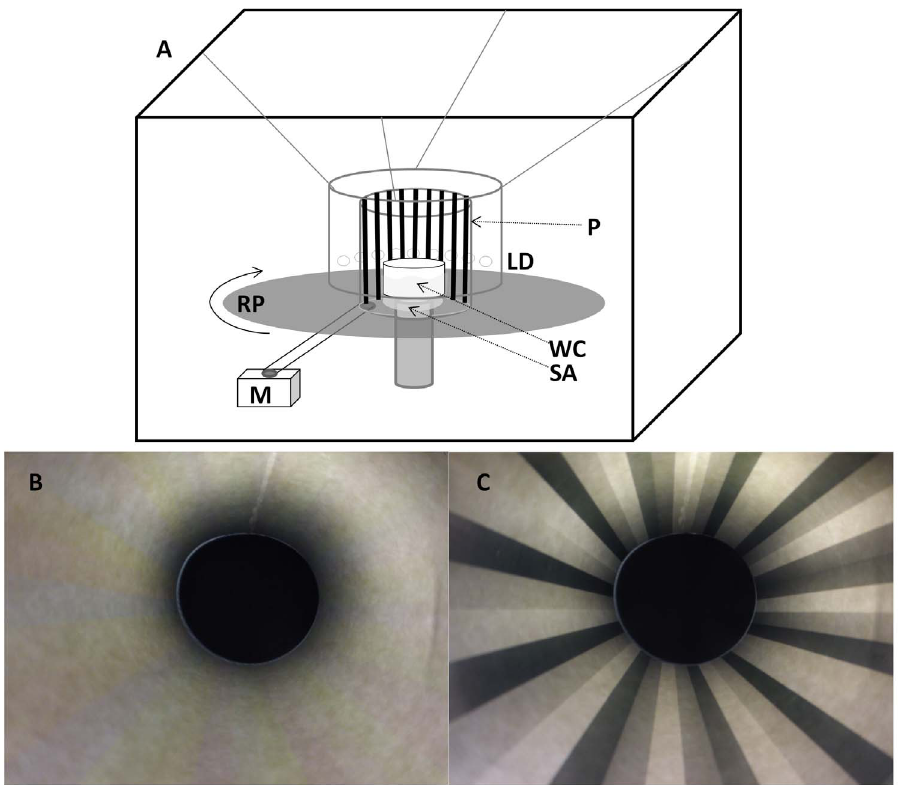
Figure 1. The optomotor apparatus. (A) The optomotor consisting of: a water container (WC), a stationary arena (SA), a rotating platform (RP), an electric motor (M), an experimental pattern (P), light emitting diodes- LEDs (LD). (B) The polarized experimental pattern photographed from the stationary arena looking upwards, (C) same image as B, but viewed through a polarizing filter. (Fig. 2B; diameter: 16.3 cm, side-wall height: 1.5 cm), which